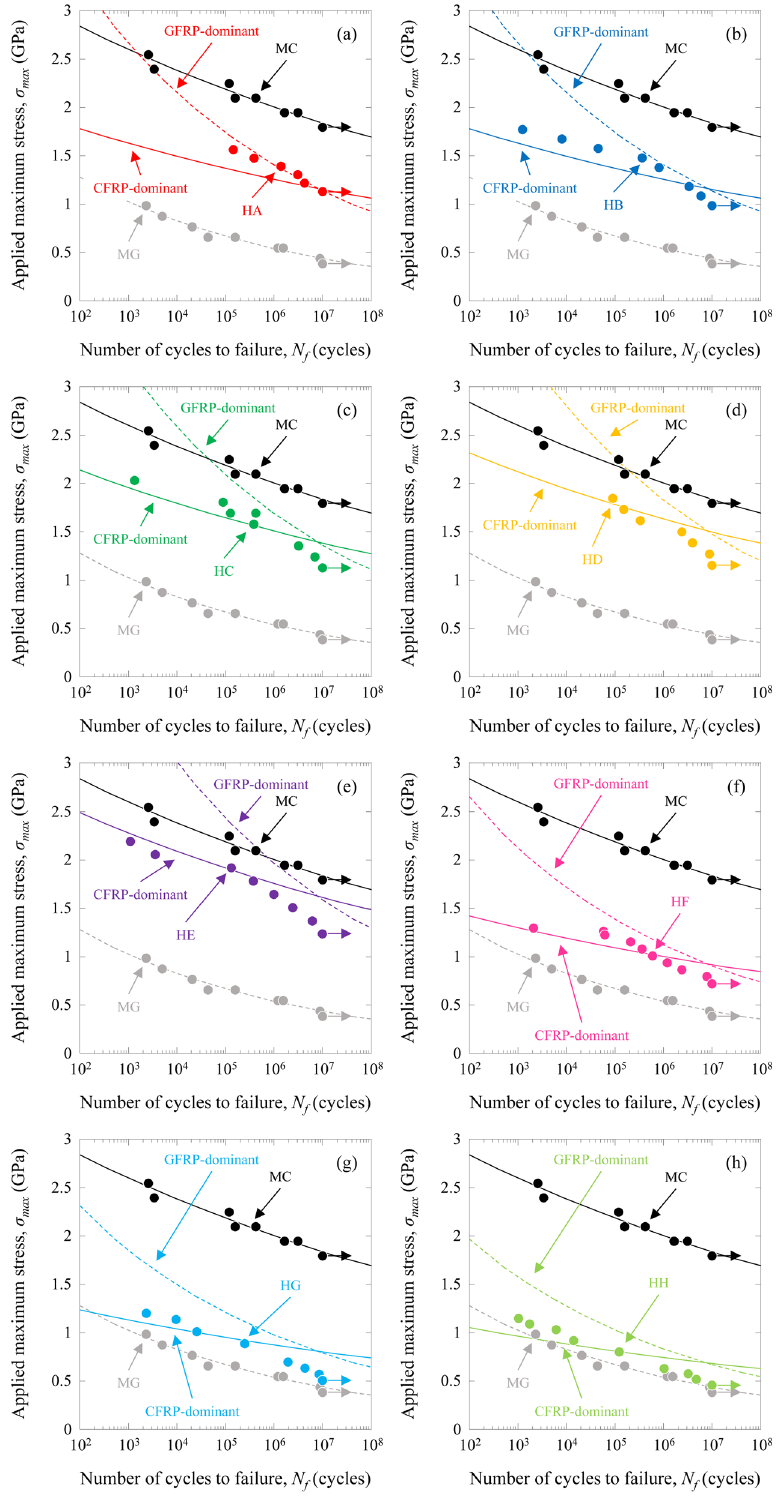
Figure 2. Relation between the applied maximum stress and the number of cycles to failure, S – N curves, for the HFRP specimens. ( a ) HA ([(0 (IMS60) )/(0 (E-glass) )] S ), ( b ) HB ([(0 (E-glass) )/(0 (IMS60) )] S ), ( c ) HC ([(0 (E-glass) )/ (0 (IMS60) ) 2 ] S ), ( d ) HD ([(0 (E-glass) )/(0 (IMS60) ) 3 ] S ), ( e ) HE ([(0 (E-glass) )/(0 (IMS60) ) 5 ] S ), ( f ) HF ([(0 (E-glass) ) 2 /(0 (IMS60) )] S ), ( g ) HG ([(0 (E-glass) ) 3 /(0 (IMS60) )] S ), and ( h ) HH ([(0 (E-glass) ) 5 /(0 (IMS60) )] S